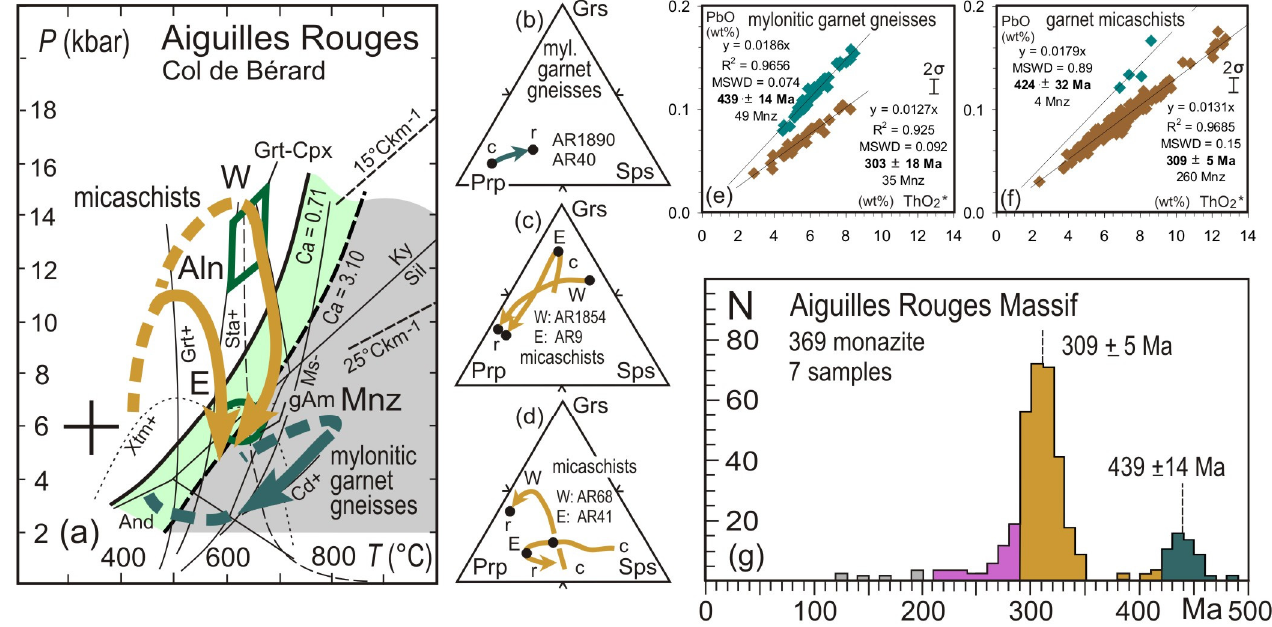
Figure 3. P-T paths, garnet zonations and EPMA Th-U-Pb monazite ages in the Aiguilles Rouges Massif (External Massif, Helvetic Domain). ( a ) P-T paths by microstructurally controlled geothermobarometry from garnet core-to-rim zonations in micaschists and paragneisses in the west (W) and the east (E) of studied area [47]. Aluminosilicates (and Ky, Sill), cordierite-in (Cd+), muscovite-out (Ms-) and staurolite-in and -out (Sta+, Sta-) univariant lines [30]. Stability fields (green and gray) of monazite (Mnz) and allanite (Aln) at different bulk rock contents as a function of Ca wt%; xenotime (Xtm) stability field. Bold cross marks uncertainty of ±50 °C/±1.0 kbar on P-T estimates. Geothermobarometric data from amphibolitised eclogite with garnet-clinopyroxene (Grt-Cpx) and from amphibolite with green amphibole endmember (gAm) equilibria are marked in green. ( b – d ) Grossular-pyrope-spessartine (Grs-Prp-Sps) ternary diagrams of garnet core-to-rim (c, r) zonations, colors of arrows are related to the P-T paths in (a). ( e , f ) ThO 2 *-PbO (wt%) isochrone diagrams. ThO 2 * is ThO 2 +UO 2 equivalents expressed as ThO 2 . General minimal 2 σ error on monazite PbO analysis is shown by a bar. Regression lines of monazite populations marked by colours give a coefficient of determination R 2 and were forced through zero [9,10]. Weighted average ages in Ma with MSWD and minimal error of 2 σ were calculated from the single analyses belonging to an isochrone [43]. The coloured symbols mark analyses belonging to monazite age populations and defining isochrones, falling into Ordovician-Silurian (blue-green) and Carboniferous (brown) ranges of ages. ( g ) Histogram of monazite ages.